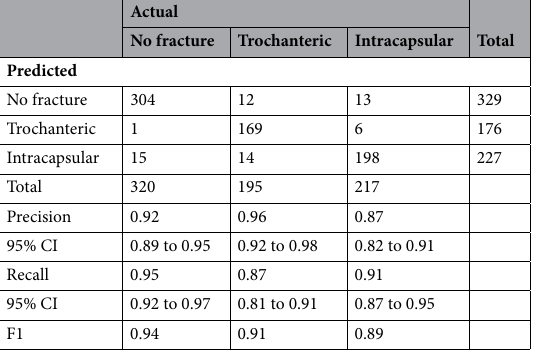
Table 1. CNN2 performance assessment. Precision = (number correctly predicted as class A)/(number predicted as class A). Recall = (number correctly predicted as class A)/(number actually of class A). F1 varies from 1 = perfect classifier for class A, to 0 = no image was correctly identified as class A.